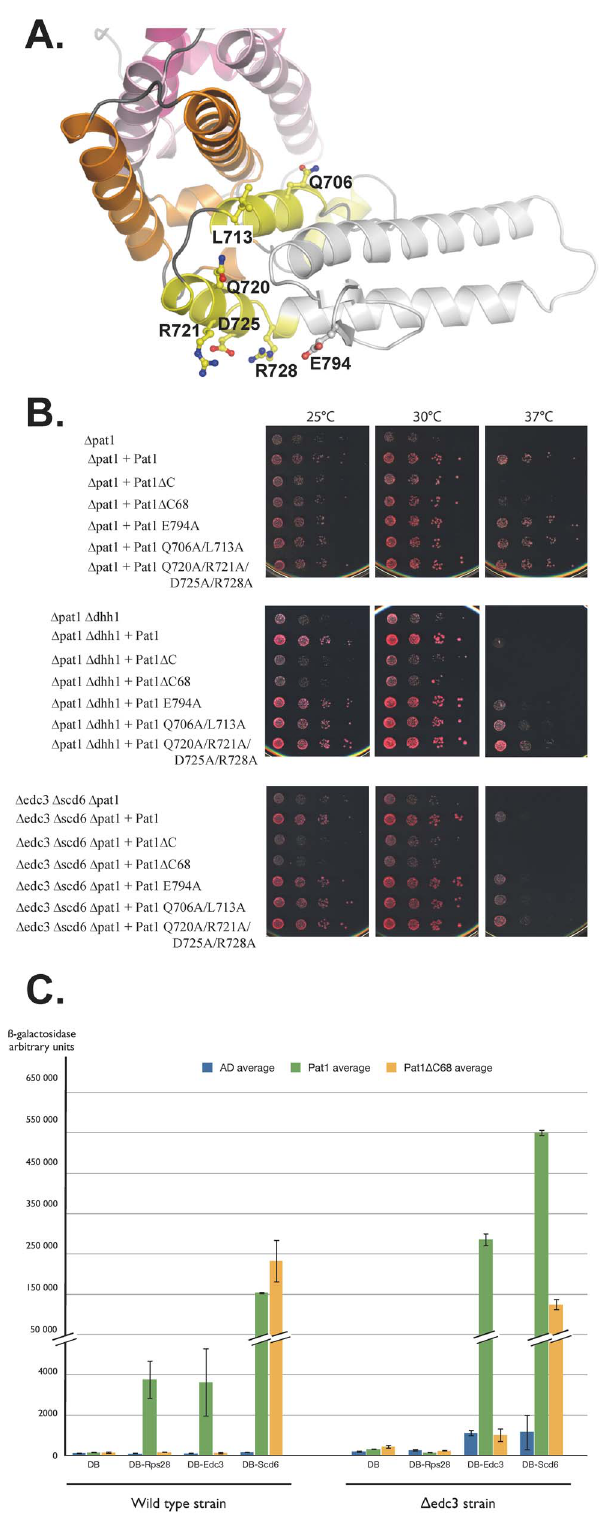
Figure 4. The yeast specific residues located at the C-terminus of ScPat1C are functionally important. A. ScPat1C structure with the residues mutated in this study shown as ball and sticks. Color scheme identical to Fig.1A. The region absent in the ScPat1 D C68 construct is colored in grey. B. Growth analysis of PAT1 mutants. Serial dilutions of the different strains transformed with vector, a